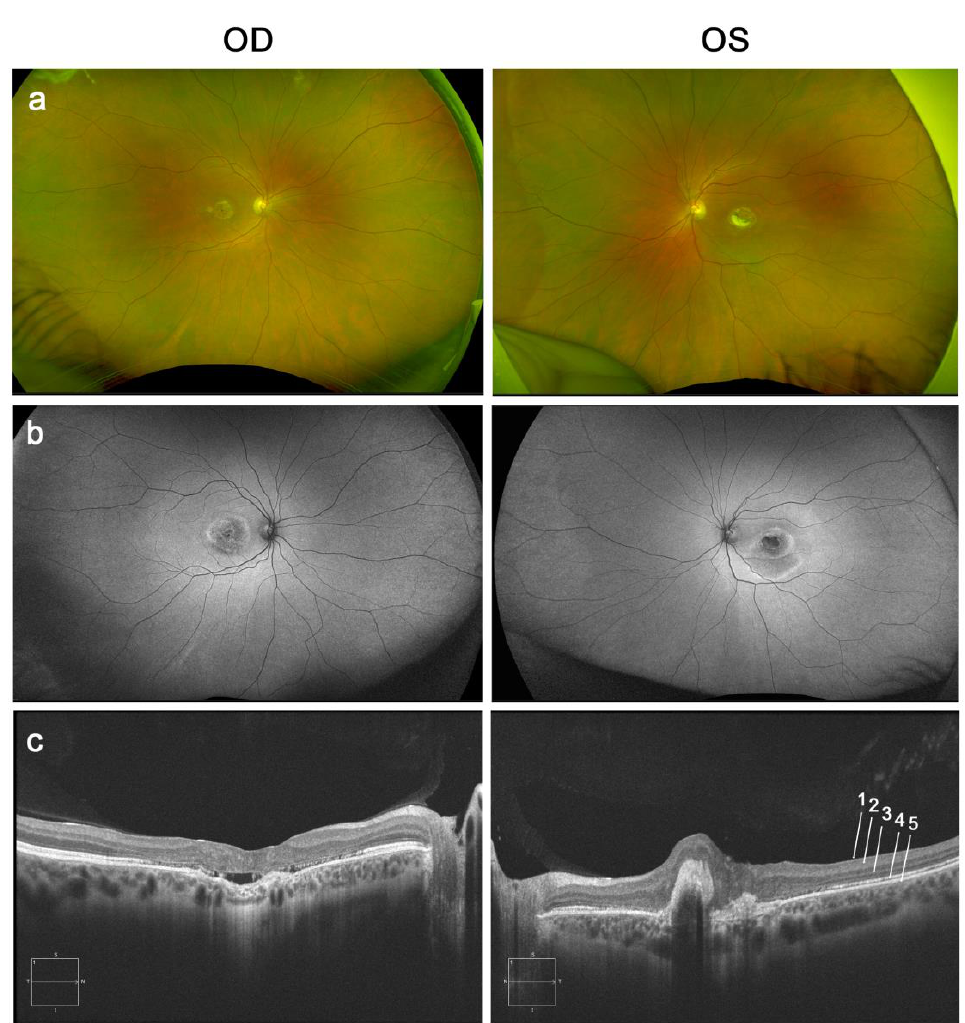
Figure 1. Patient’s clinical description. ( a ) Wide Fundus Retinography and ( b ) wide Fundus Autoflorescence (AF) at the age of 38-years and ( c ) macular Optical Coherence Tomography (OCT) at the age of 35-years of both eyes. Layers of the retina are shown in OCT: 1: Internal limiting membrane, 2: Nerve Fiber Layer, 3: Ganglion cell, inner plexiform, inner nuclear, and outer plexiform layer, 4: Photoreceptor outer nuclear layer, 5: RPE/Bruch’s complex. 2.2. Fi21/01 iPS-RPE Cells Don’t Show Differential Levels of BEST1 mRNA Expression or